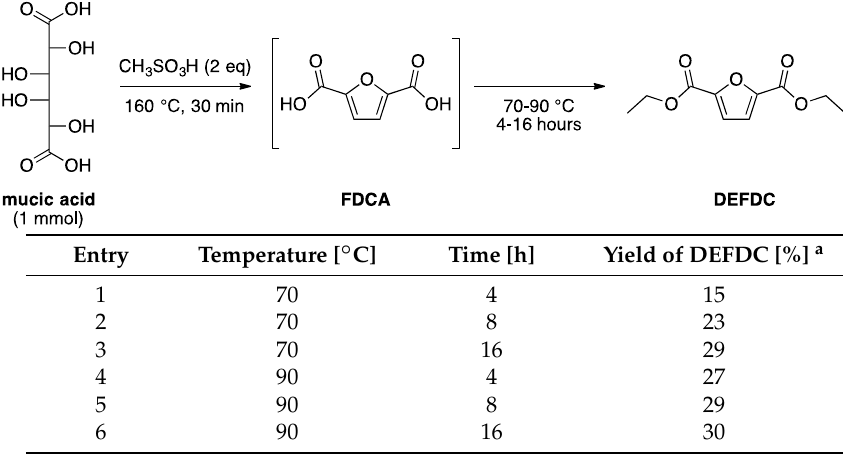
Table 2. Production of DEFDC starting from mucic acid in a one-pot two steps reaction.